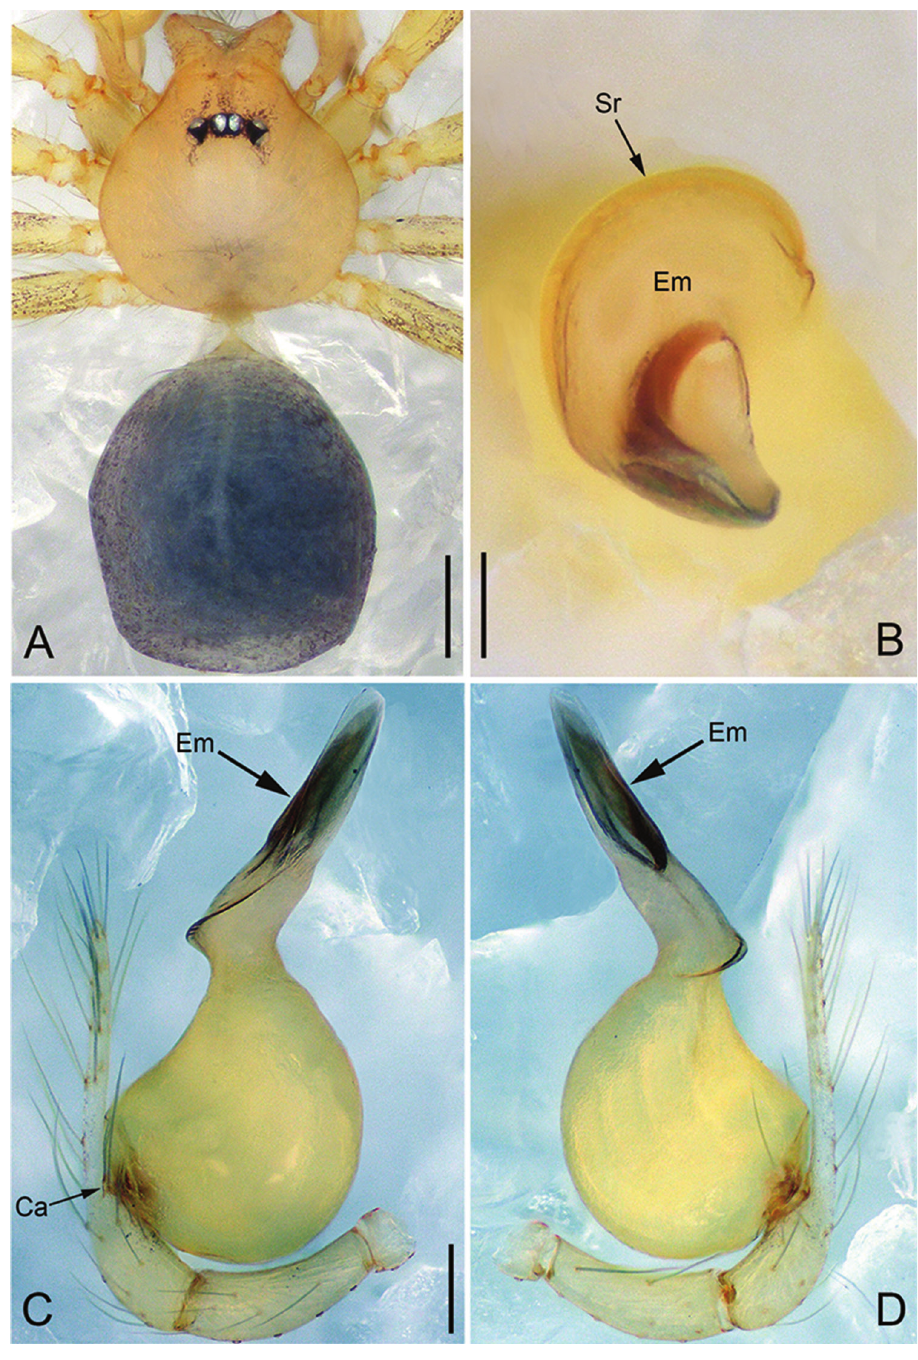
Figure 13. Pinelema lizhuang Zhao & Li, sp. n., male holotype. A Habitus, dorsal view B Embolus, apical view C Palp, prolateral view D Palp, retrolateral view. Scale bars: 0.2 mm ( A ), 0.05 mm ( B ), 0.1 mm ( C–D